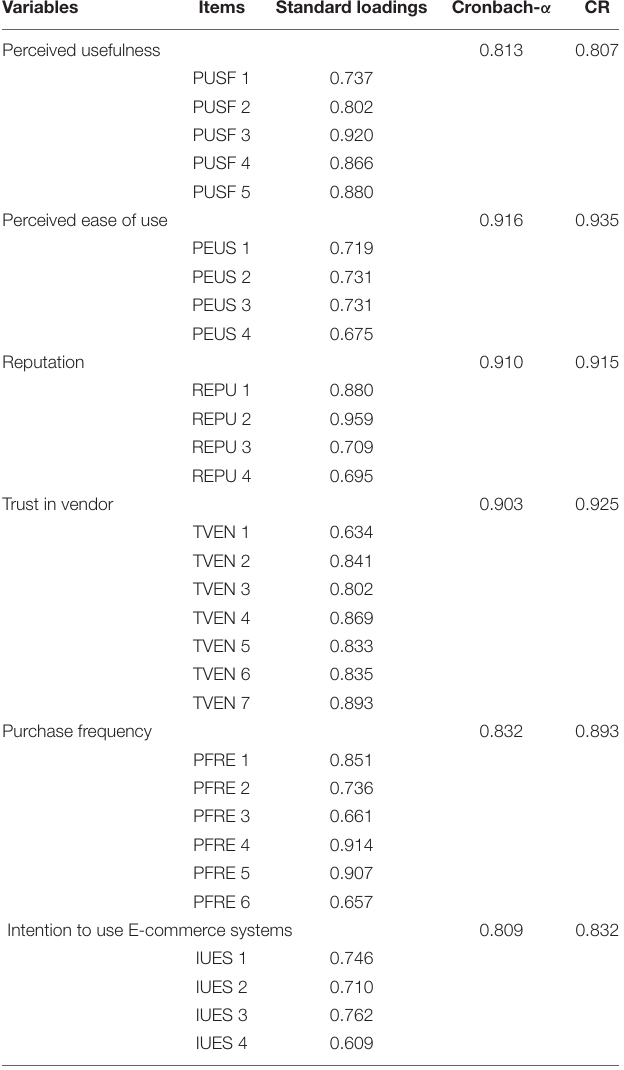
TABLE 4 | The results of reliability analysis and factor loadings.